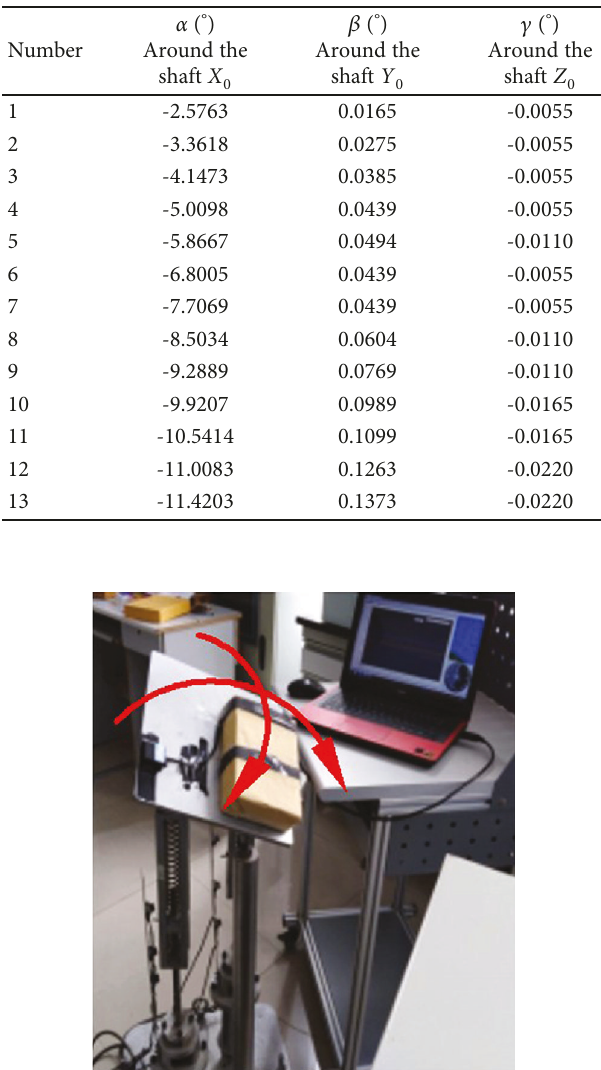
Table 5: Angle changes for the upper platform.